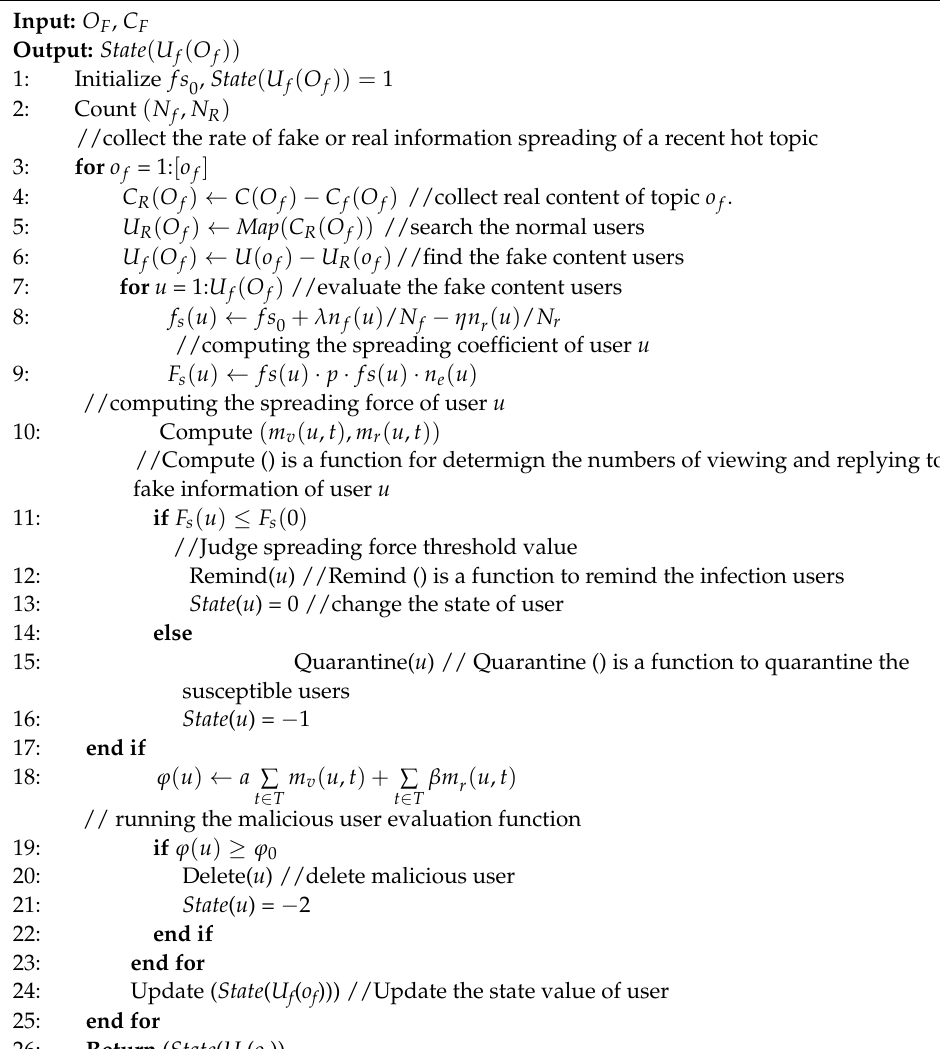
Algorithm 2. Fake information users controlling